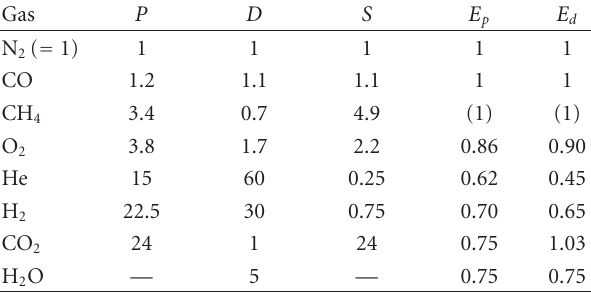
Table 1: Relative value of permeability parameters (no-dimensional value).